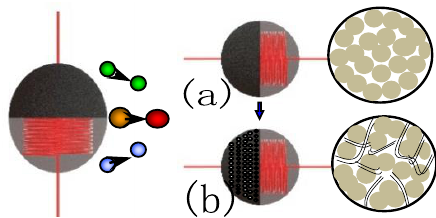
Figure 11. Schematic diagram of doped MWNT microchannel. ( a ) Carrier bead without MWNT. ( b ) Carrier bead doped MWNT.